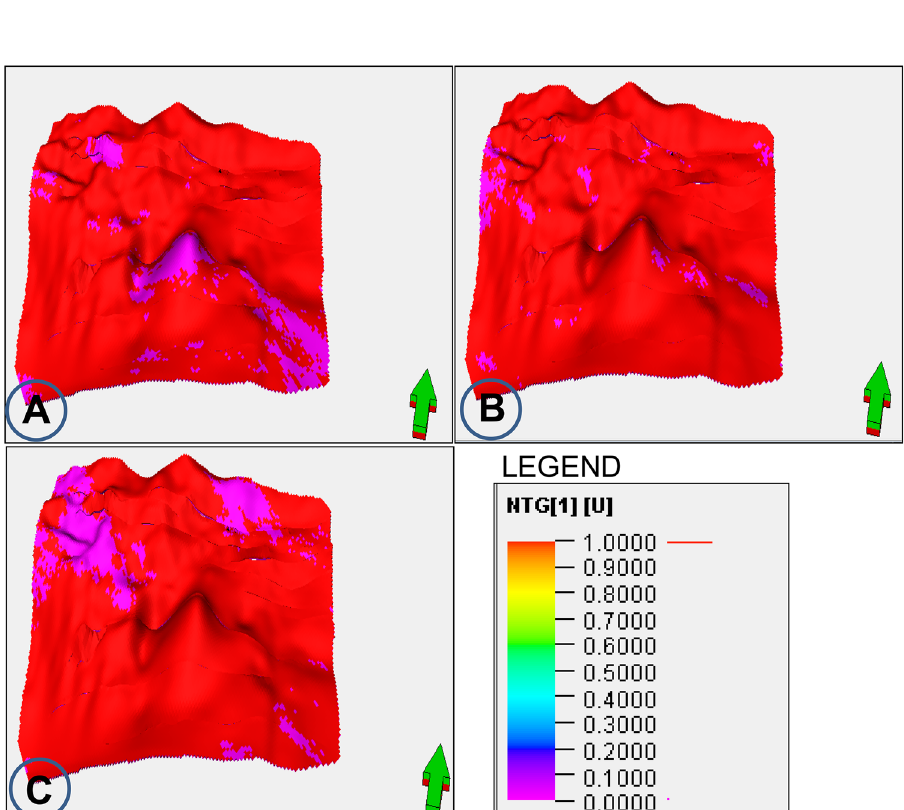
Fig. 13 Equiprobable realiza- tions of net-to-gross from K300